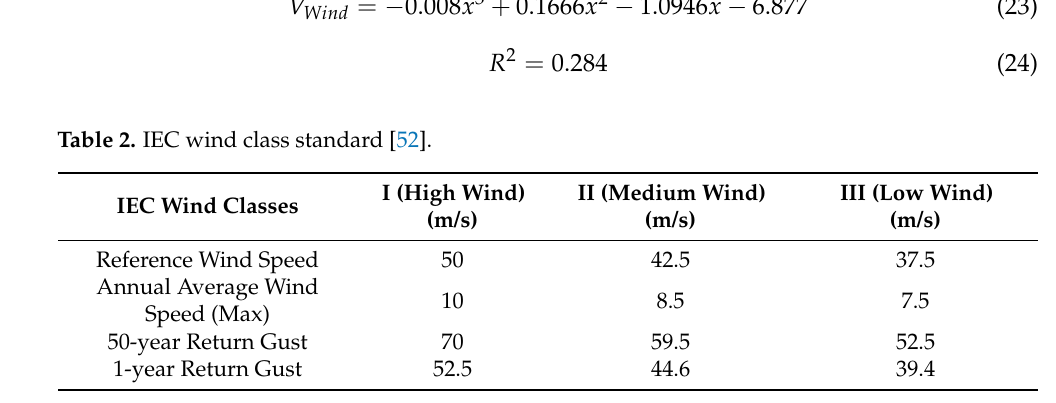
Table 4. LCOE and EPC.